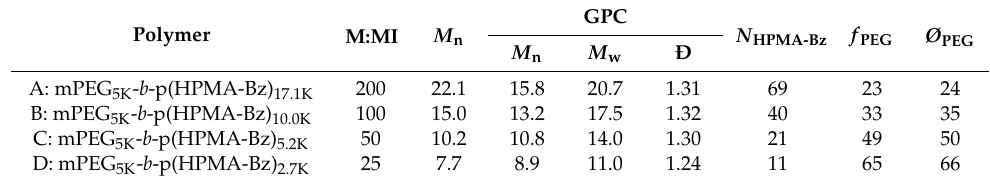
Table 1. Characteristics of the synthesized poly(ethylene glycol)- b -poly( N -2-benzoyloxypropyl methacrylamide) mPEG 5K - b -p(HPMA-Bz) x block copolymers as determined by 1 H-NMR and gel permeation chromatography